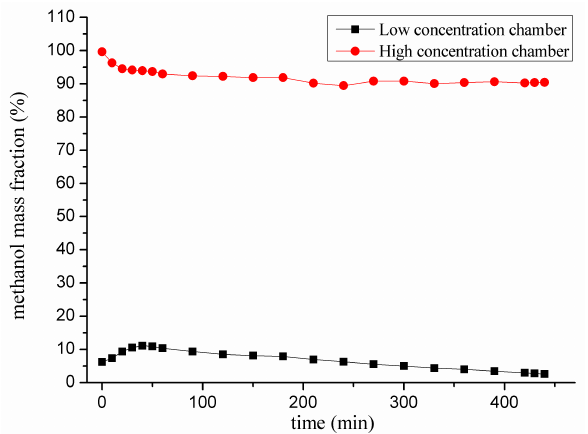
Figure 2. ( a ) Structures of the surface treated PTFE membranes; ( b ) structures of the Nafion-PTFE composite membranes.